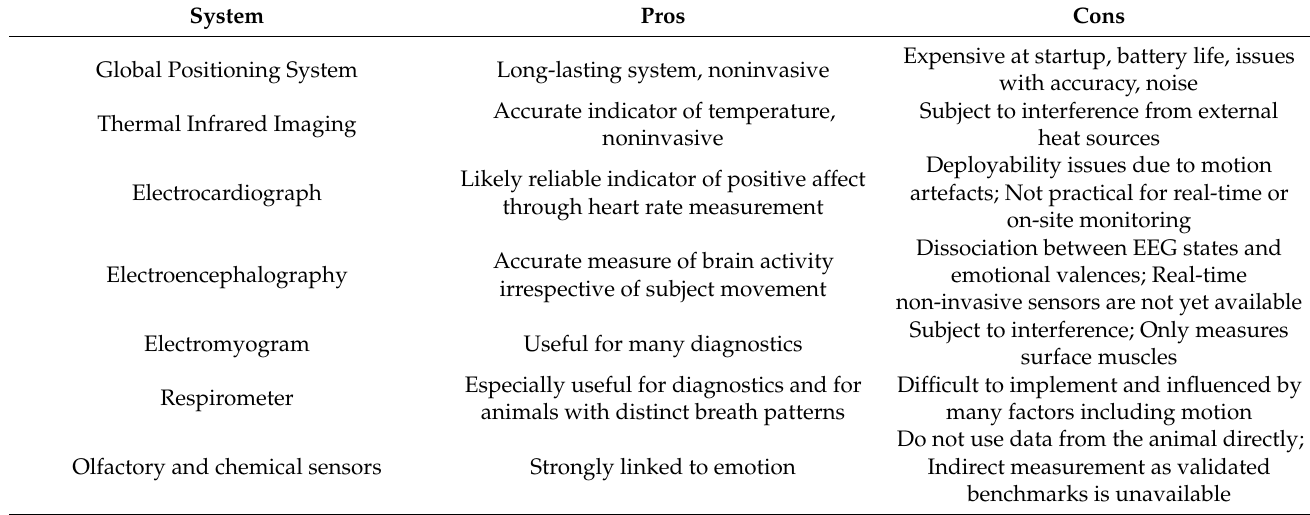
Table 2. Pros and cons of different sensor systems related to emotions measurement. System Global Positioning